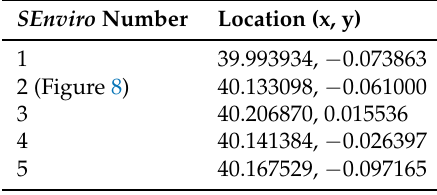
Table 1. Locations of SEnviro nodes used in this project.